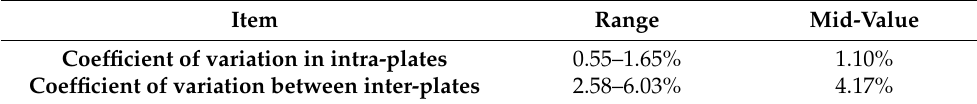
Table 3. The results of the repeatability test using the developed competitive